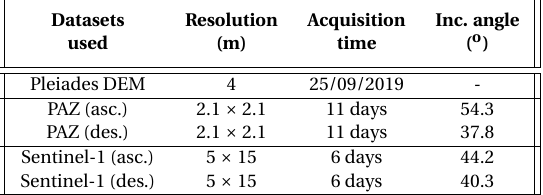
Table 1. Datasets used in the